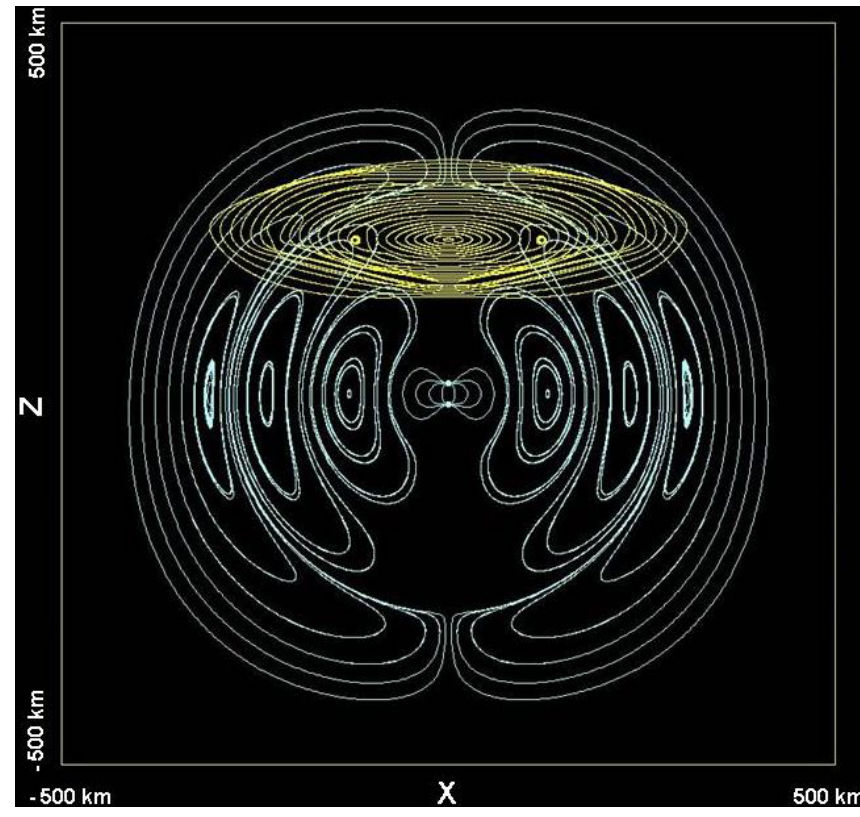
Fig. 2. A 3-D spherical wave in the HYB-em model. The run includes an oscillating point source in a vacuum located at the center of the figure. The source generates a sinusoidal electric field with a frequency of 1.5kHz. The white lines and the yellow lines are the electric and the magnetic field lines, respectively, which are added to illustrate the electromagnetic field in 3-D. The horizontal axis and the vertical axis are the x- and the z-axis, respectively. The size of the box is − 500km < x,y,z < 500km. Note that the vantage point is slightly (10 deg.) below the z =0 plane in order to see the circular B-lines about the